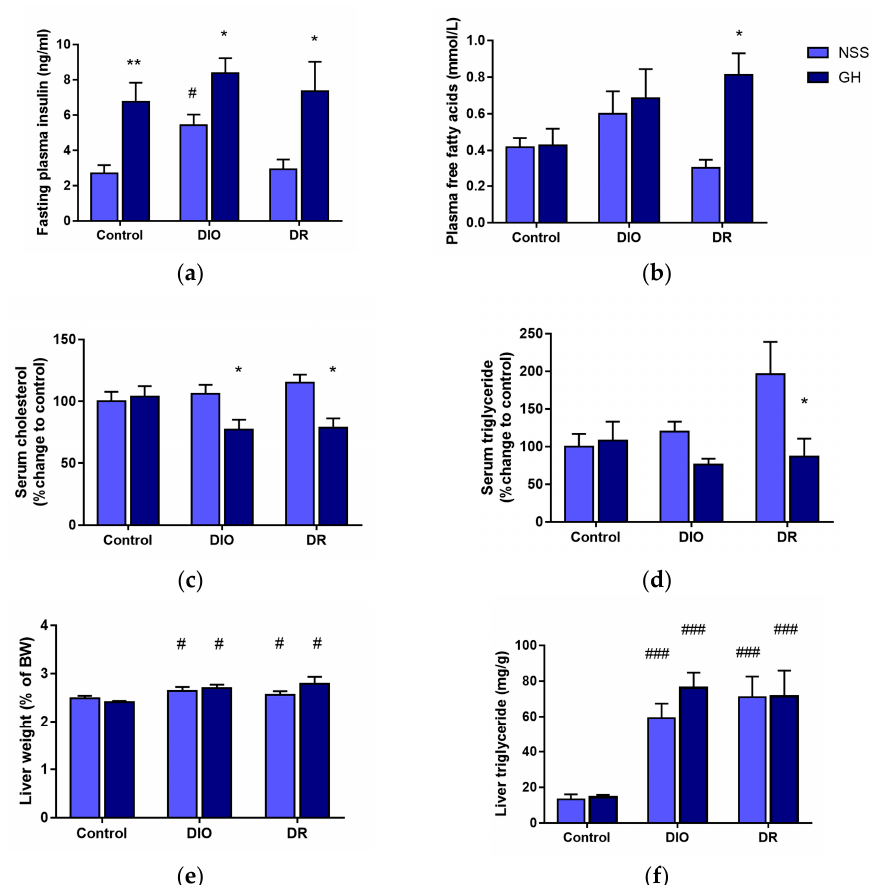
Figure 4. ( a ) Plasma insulin after short-term GH administration; *, ** represent statistical significance between GH and NSS groups ( p < 0.05, p < 0.01, respectively), # represents statistical significance when compared to the control group ( p < 0.05). ( b ) Plasma free fatty acids after short-term GH administration; * represents statistical significance between GH and NSS groups ( p < 0.05). ( c ) Serum cholesterol levels (% change to the control group) after short-term GH treatment; * represents statistical significance between GH and NSS groups ( p < 0.05). ( d ) Serum triglyceride levels (% change to the control group) after short-term GH treatment; * represents statistical significance between GH and NSS groups ( p < 0.05). ( e ) The percentage of liver weight in each group; # represents statistical significance when compared to the control group ( p < 0.05). ( f ) Liver triglyceride concentration (mg/g tissue) in each group; ### represents statistical significance when compared to the control group ( p < 0.001). All results are presented as mean ± SEM; n = 6 per experimental group (NSS/GH of control and DIO rats), n = 5 per experimental group (NSS/GH of DR